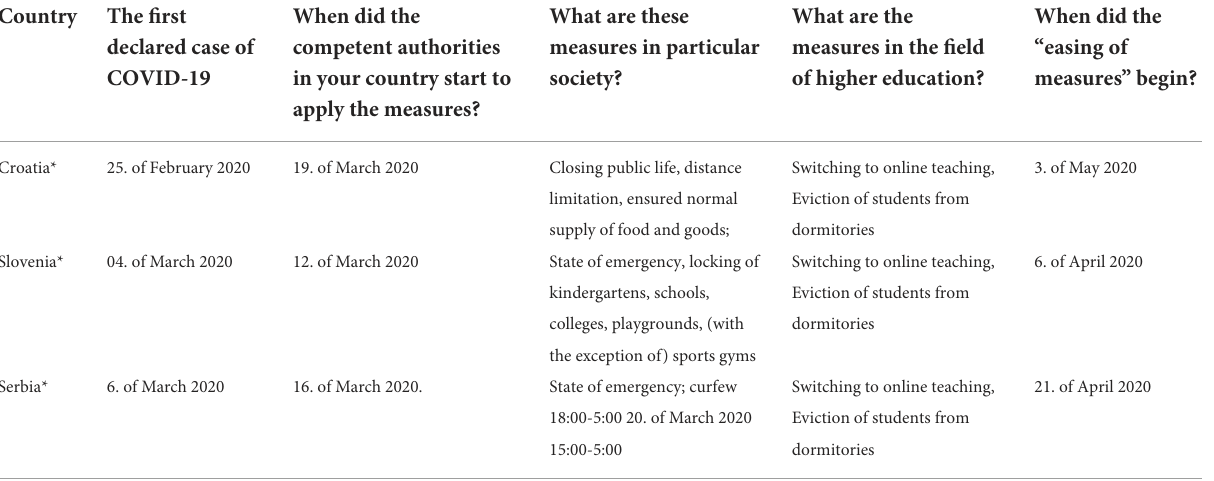
TABLE 1 Emergency measures in Croatia, Slovenia and Serbia in the first wave of COVID-19 (review of everyday life and university education). Country The first